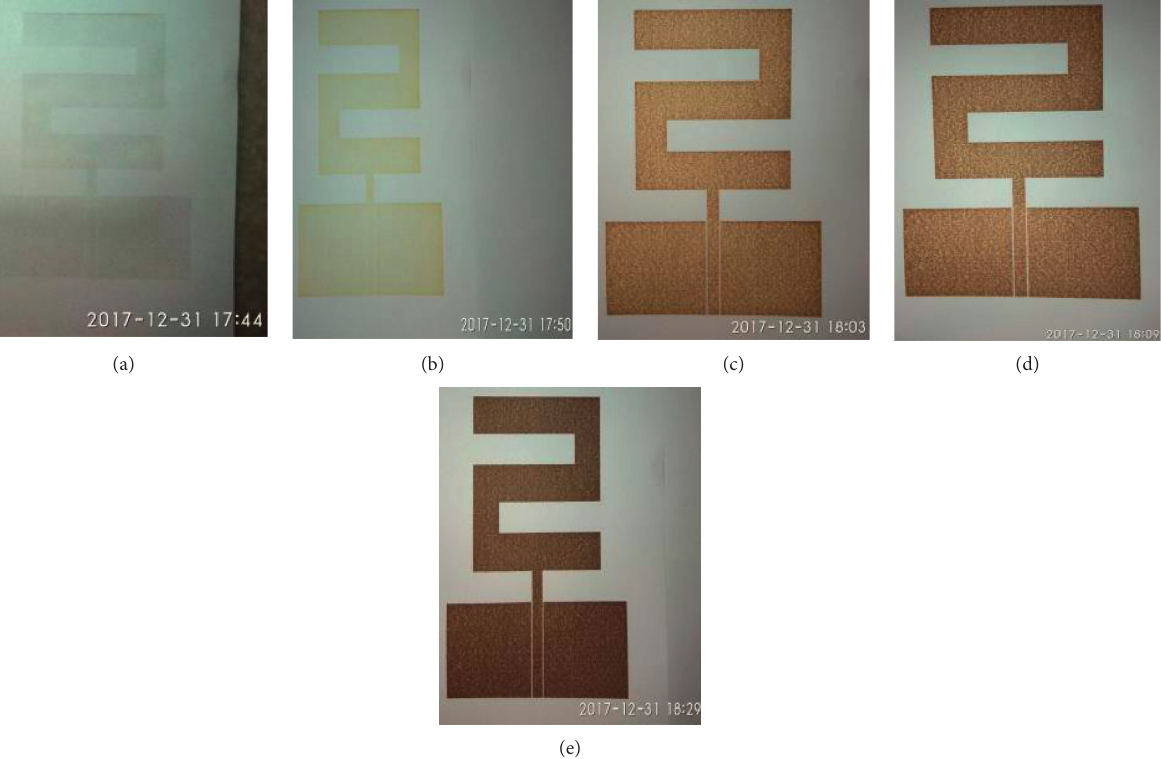
Figure 10: Curing of inkjet printing antenna at different time instants: (a) at time 17.44, (b) at time 17.50, (c) at time 18.03, (d) at time 18.09, and (e) at time